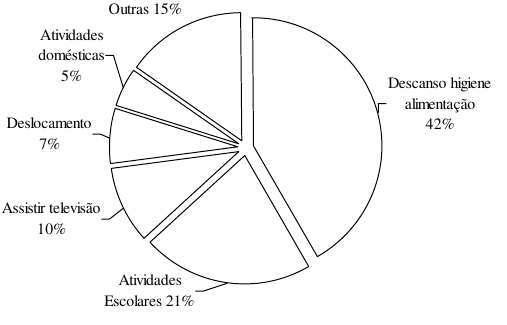
Figura 1. Uso do tempo na semana por adolescentes de classe popular. No fim de semana as atividades escolares diminuem para 2,43%, continuando a prevalecer atividades de descanso, higiene e alimentação e assistir a televisão, à qual é dedi- cado o percentual de 11% do tempo. Destacam-se a seguir as atividades de lazer fora de casa, conforme ilustrado na Figura 2.